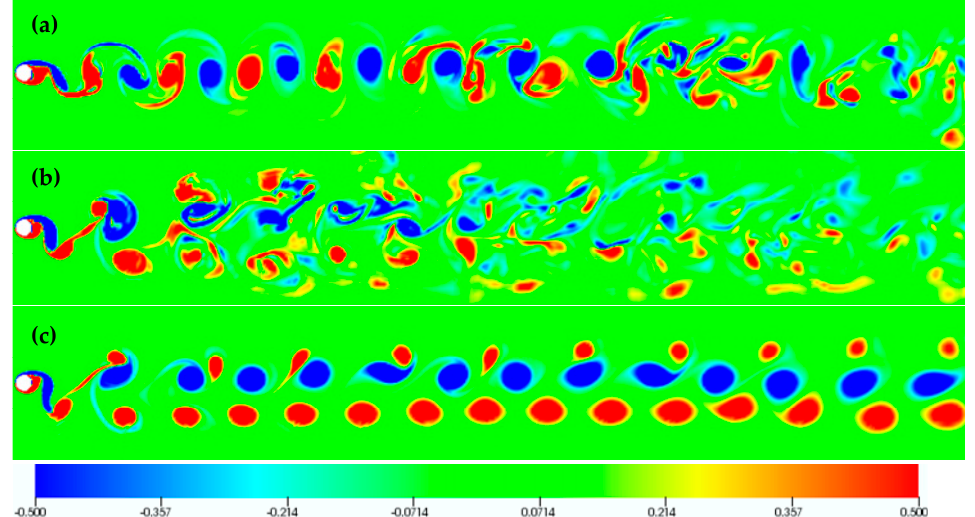
Figure 13. Clockwise cylinder oscillation: Instantaneous isocontours of spanwise vorticity for the plane z = 3 for F = 0.9 and ( a ) A y /D = 0.20, ( b ) A y /D = 0.30, ( c ) A y /D = 0.40.